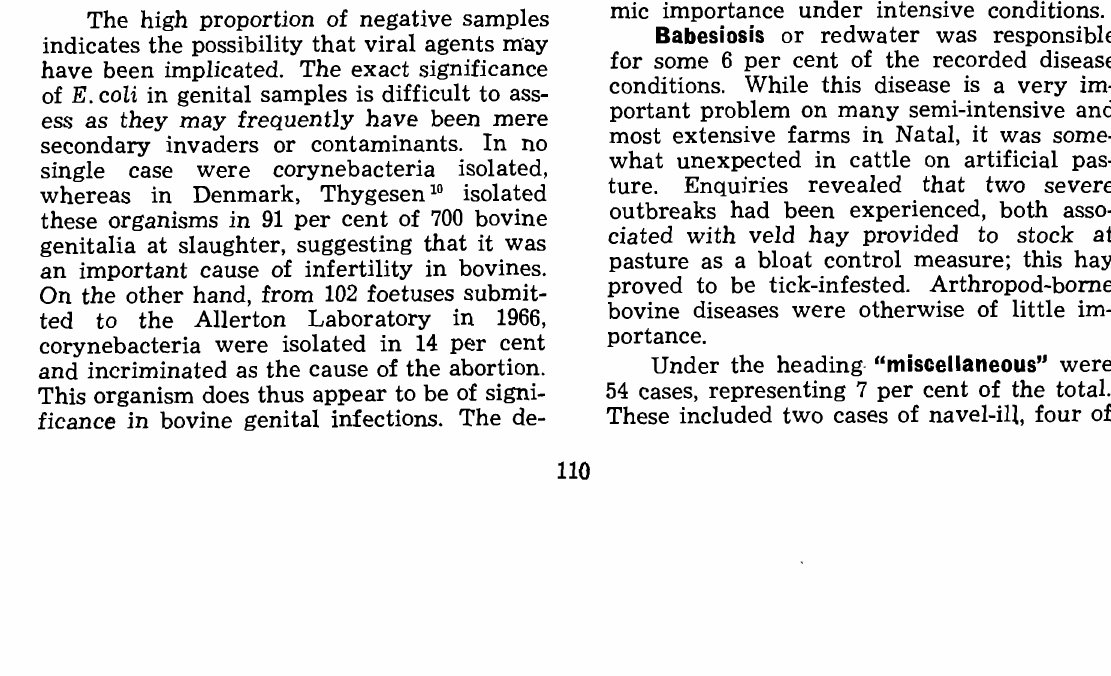
Number of samples E. coli Staphylococci